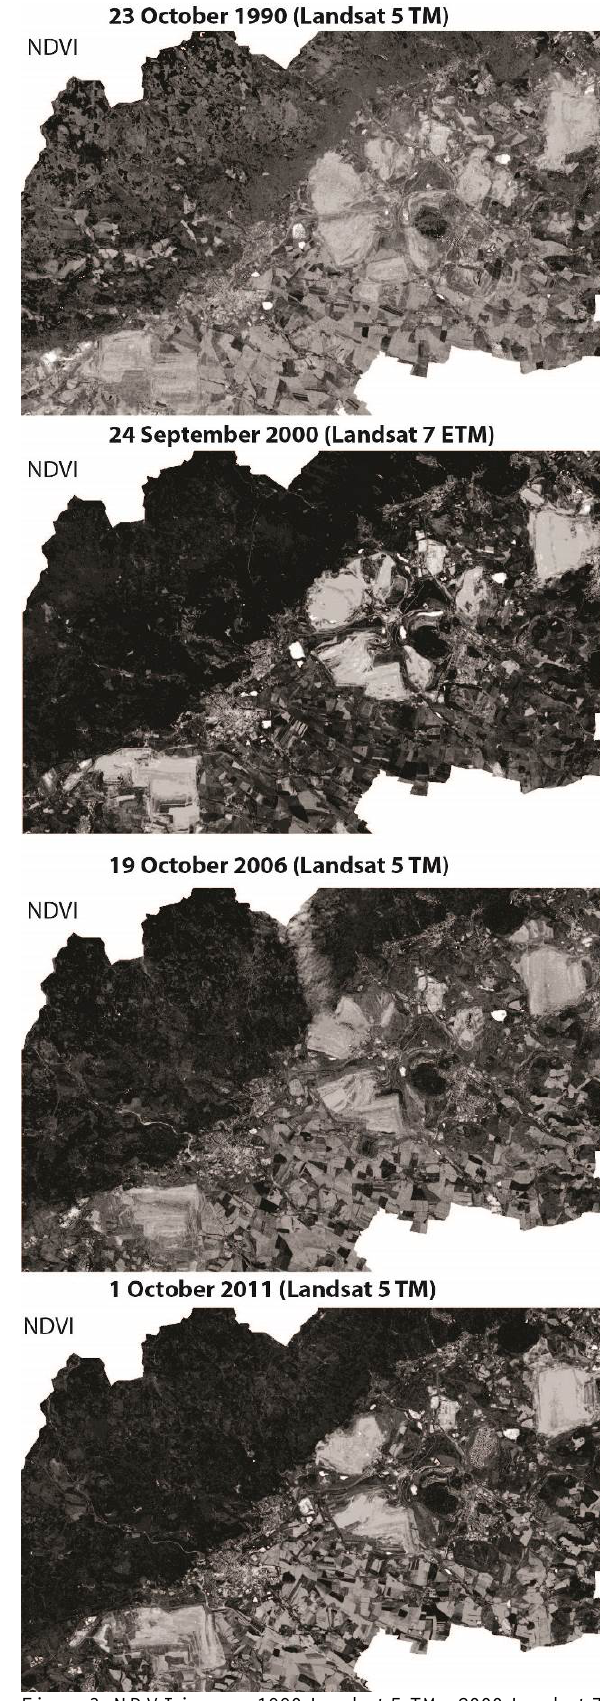
Figure 3. NDVI images: 1990 Landsat 5 TM, 2000 Landsat 7 ETM+, 2006 Landsat 5 TM and 2011 Landsat 5